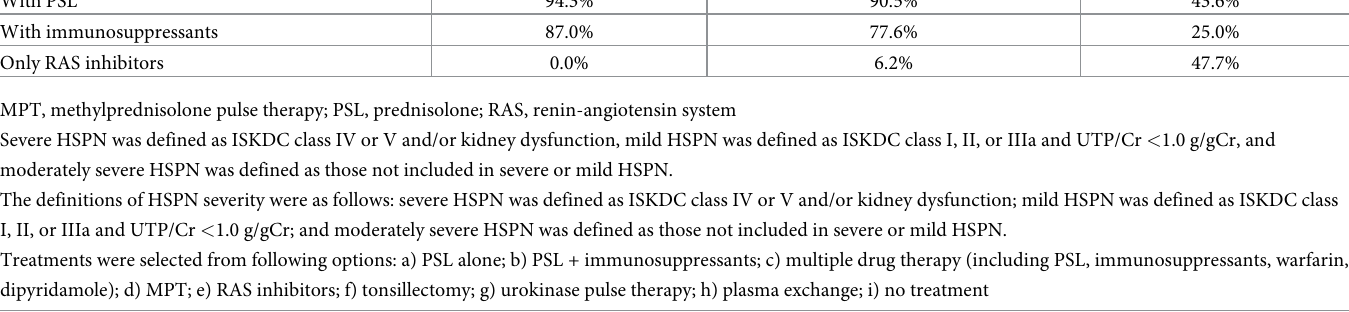
Mild cases most often received renin-angiotensin system inhibitors alone. Table 4. Treatment protocols for HSPN in individual institutions. Severe Moderately severe Mild With MPT 75.5% 26.2% 5.9% With PSL 94.3% 90.5% 43.6% With immunosuppressants 87.0% 77.6% 25.0% 0.0% 6.2%